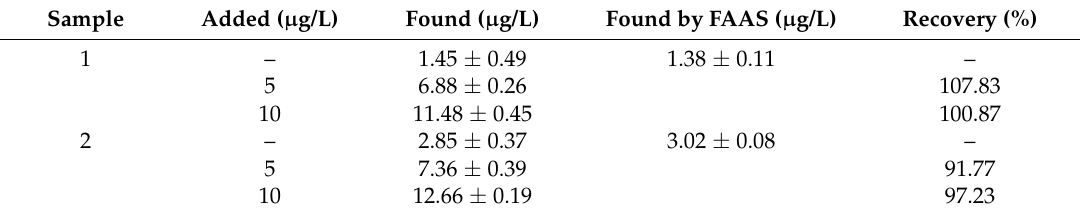
Table 3. Determination results of Cd(II) in soil